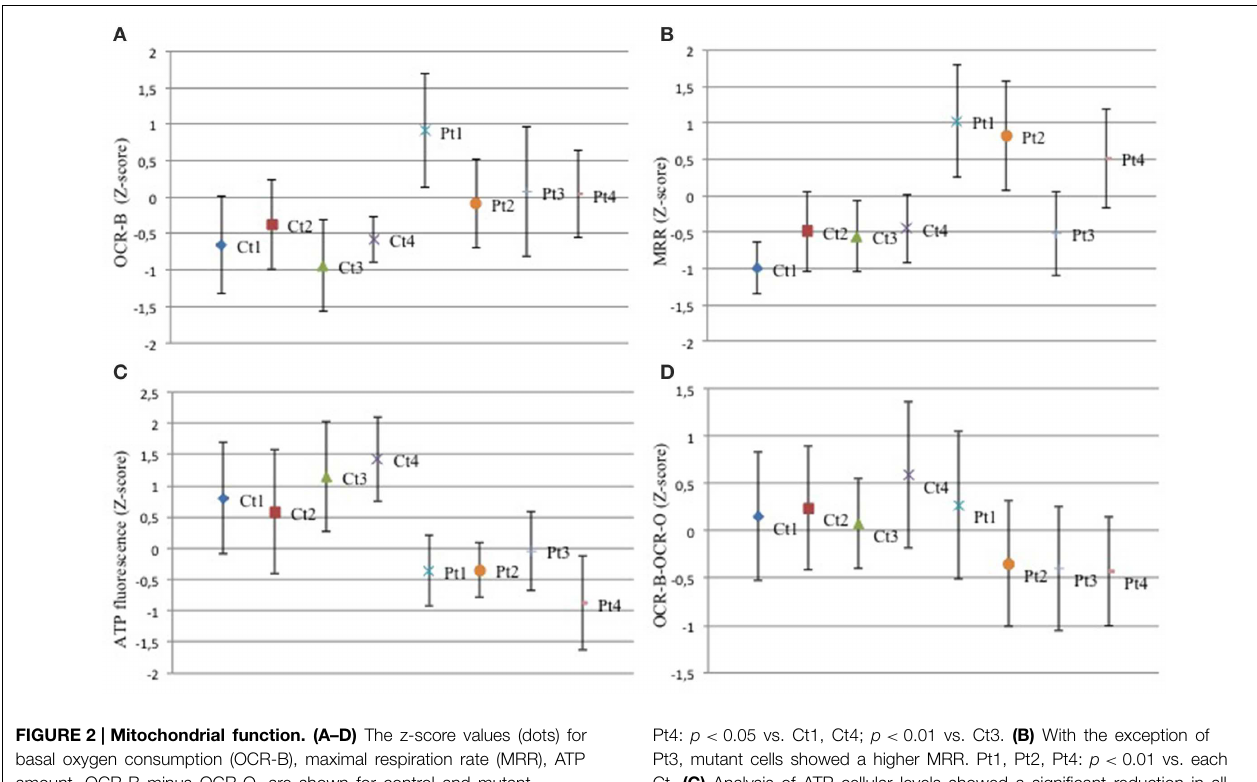
Pt4: p < 0 . 05 vs. Ct1, Ct4; p < 0 . 01 vs. Ct3. (B) With the exception of Pt3, mutant cells showed a higher MRR. Pt1, Pt2, Pt4: p < 0 . 01 vs. each Ct. (C) Analysis of ATP cellular levels showed a significant reduction in all mutant fibroblasts respect to controls. Pt1, Pt2, Pt4: p < 0 . 01 vs. each Ct; Pt3: p < 0 . 05 vs. Ct1, Ct2; p < 0 . 01 vs. Ct3, Ct4. (D) The difference between OCR-B and OCR-O has a trend toward reduction in mutant fibroblasts respect to controls. Pt1: p < 0 . 05 vs. Ct4; Pt2, Pt3, Pt4: p < 0 . 05 vs. Ct1, Ct2,